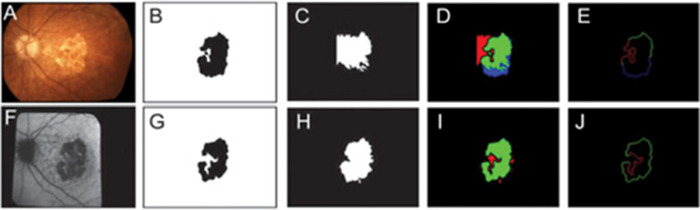
Examples of image segmentation using the Fuzzy c-Means algorithm reported by Ramsey et al.31 Top row illustrates CFP-based segmentation and the bottom row FAF-based segmentation. B and G are ground truths, C and H are segmentation results, D and I are color coded maps of segmentation results, and E and J illustrate which GA borders were correctly identified (i.e. green). See also the website of MathWorks (https://www.mathworks.com/discovery/image-segmentation.html) for many other examples of image segmentation.